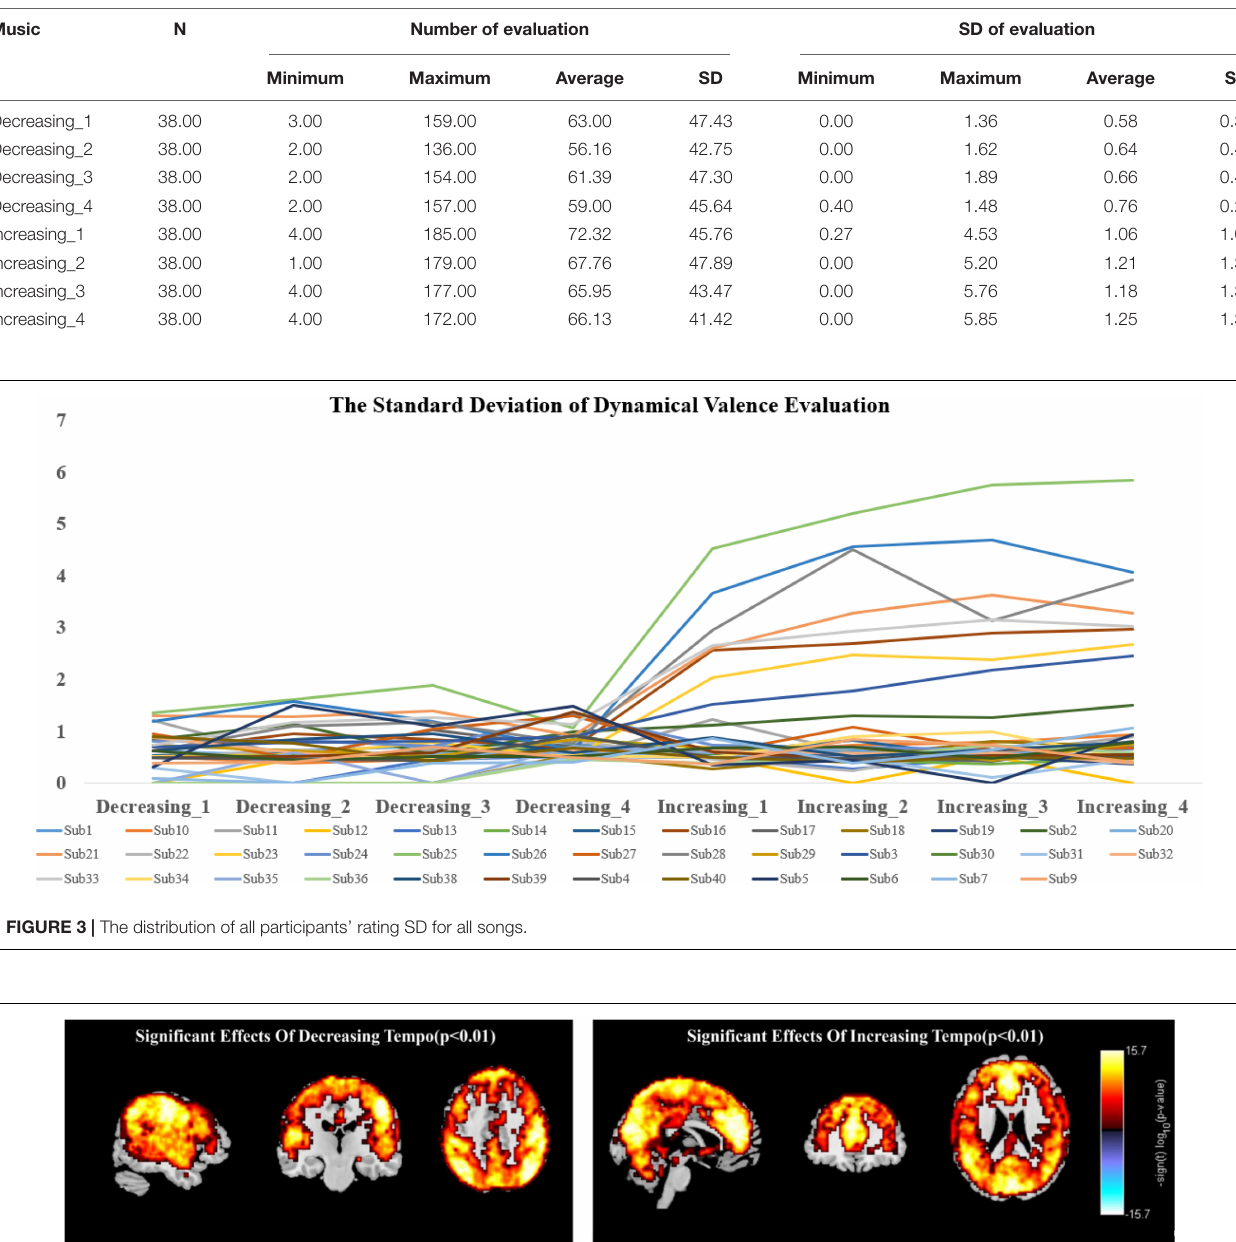
TABLE 3 | The rating number and SD of each song.